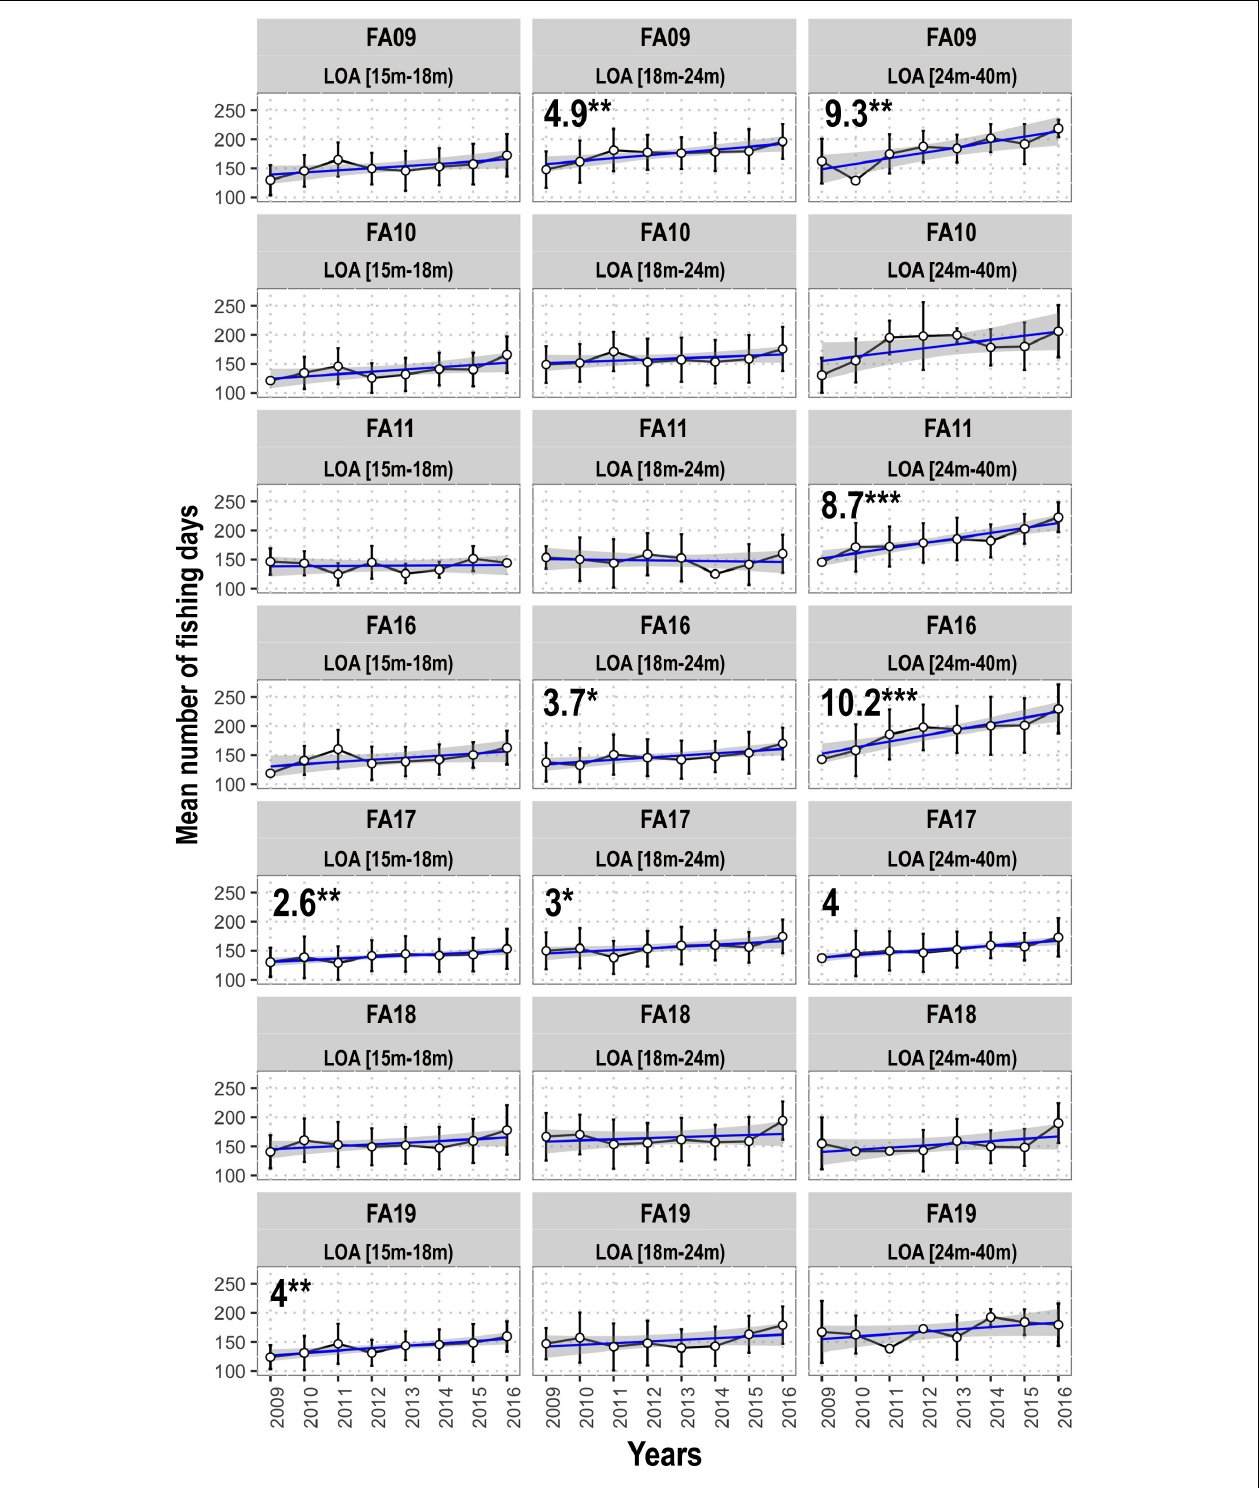
FIGURE 4 | Trends of the mean l number of fishing days by year, FA and length class, as obtained by the analysis of VMS data. The significant coefficients, as number of additional fishing days by year, are reported and marked by ∗ p < 0.05 or ∗∗ p < 0.005.